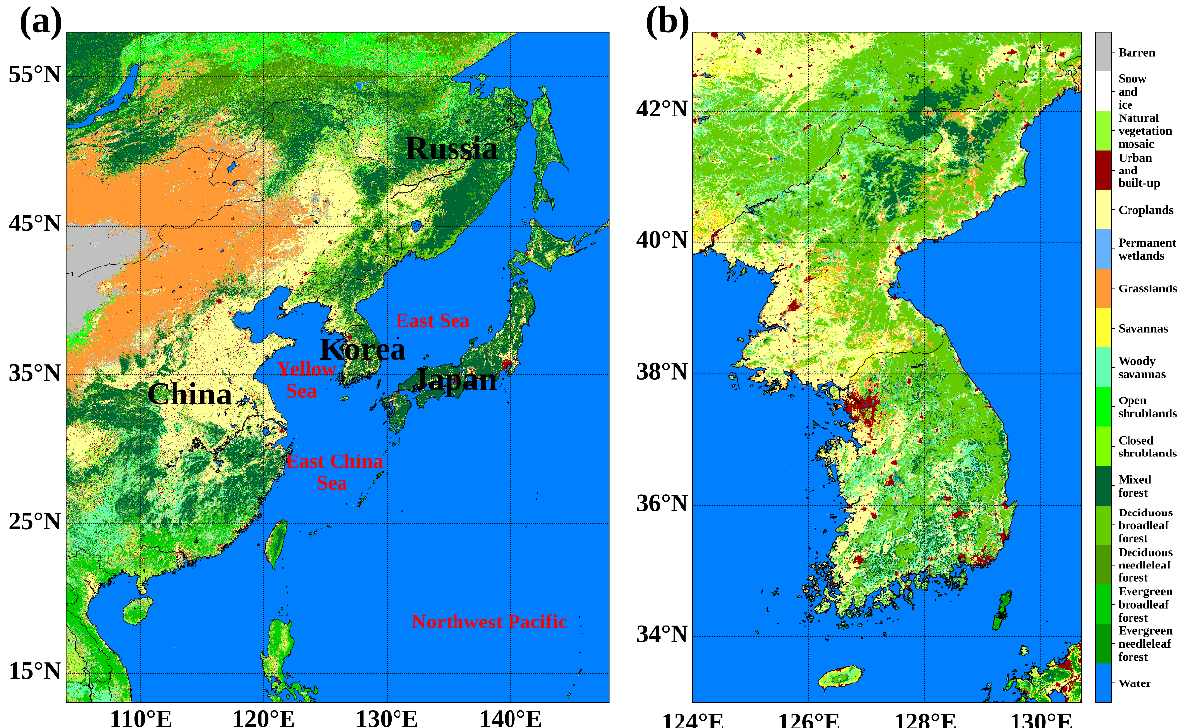
Figure 1. MODIS land cover from the Annual International Geosphere-Biosphere Programme over ( a ) Northeast Asia and ( b ) the Korean Peninsula in 2019.